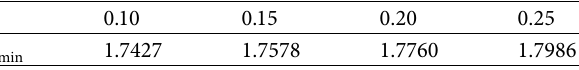
Table 2: Diferent performance c � h . h M